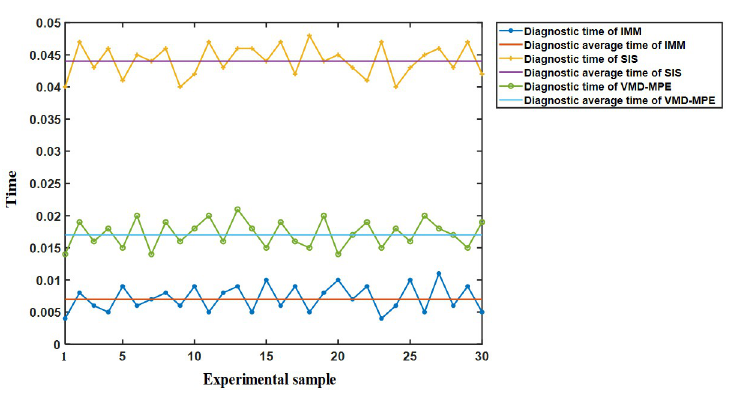
Fig 14. Fault diagnosis time curve of each method.